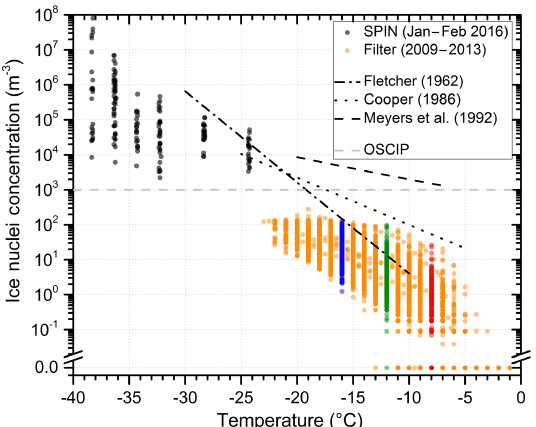
Figure 1. Cumulative ice nuclei concentration as function of tem- perature. Date and method of measurement are indicated in the fig- ure. Filter data at − 8, − 12 and − 16 ◦ C are color-coded red, green and blue. These data are shown in the same colors in subsequent figures. Parametrizations from Fletcher (1962), Cooper (1986) and Meyers et al. (1992) are given for comparison. All parametriza- tions are shown in their valid temperature range. The OSCIP (Onset of Significant Concentrations of Ice Particles; Rangno and Hobbs, 1988) provides a guideline concentration for effecting cloud prop- erties by primary ice nucleation.